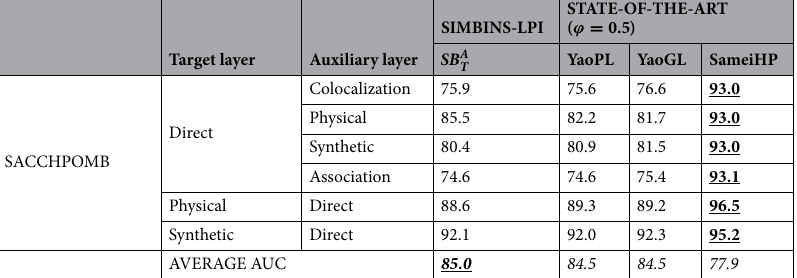
Table 4. Comparison of average AUC over 100 iterations for the networks under study with state-of-the-art methods. Performance evaluation of the link prediction methods on 52 real-world duplex networks based on AUC measure. Three left columns determine the name of the multiplex networks, the target layer of link prediction, and the auxiliary layer which comes to help the prediction task. From left to right, the evaluated methods are SimBins using LPI as base similarity measure: Our proposed method, YaoPL: a state-of-the-art method that utilizes LPI with PCC as the layer relevance measure, YaoGL: LPI with PCC as the layer relevance measure, SameiHP: a state-of-the-art method that utilizes hyperbolic distance as dissimilarity measure within each layer with GOR as the layer relevance measure. Bold and underlined are the best results in each